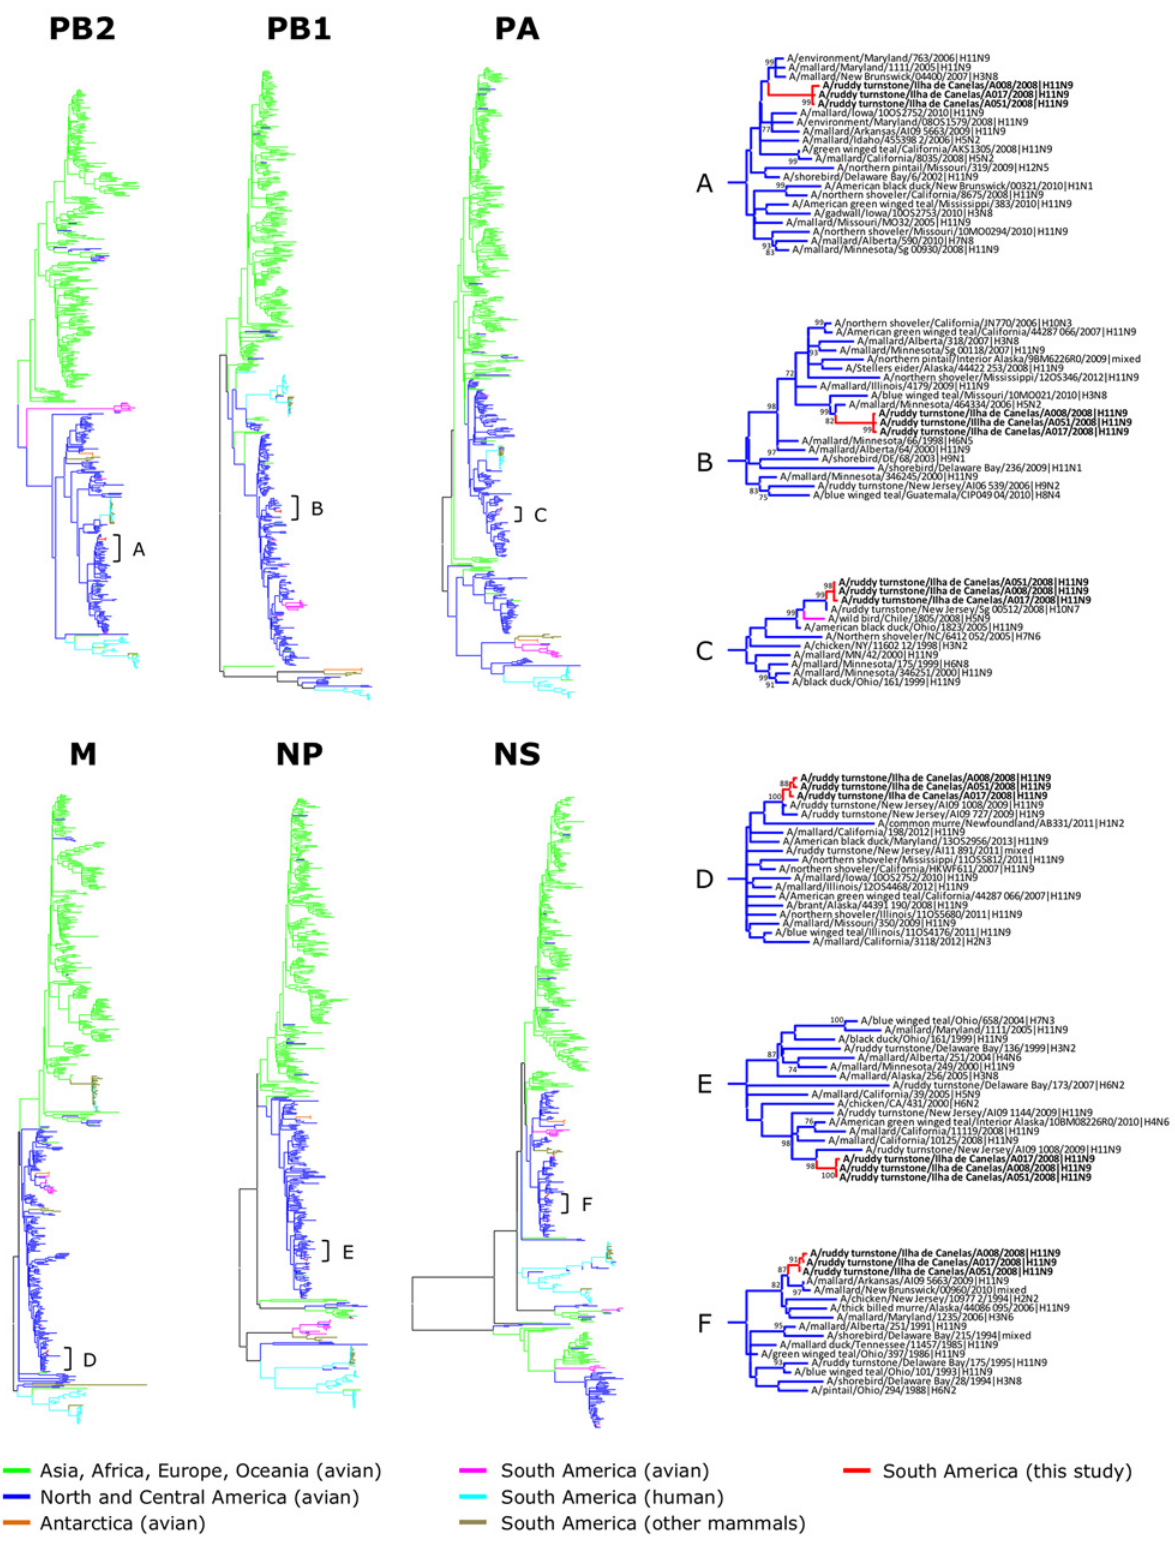
Fig 1. Phylogenetic tree of PB2, PB1, PA, M, NP and NS sequences. Trees are drawn to the similar scales, with branch lengths proportional to evolutionary distance. Bootstrap values lower than 30 are